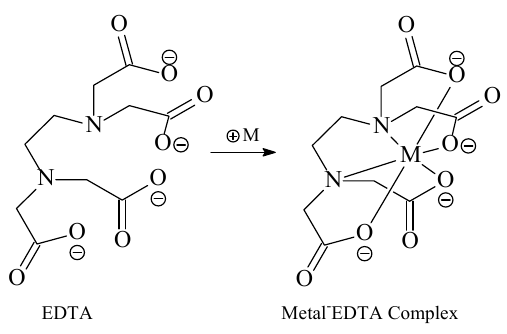
Figure 3. A representation of an ethylenediaminetetraacetic acid (EDTA) chelating